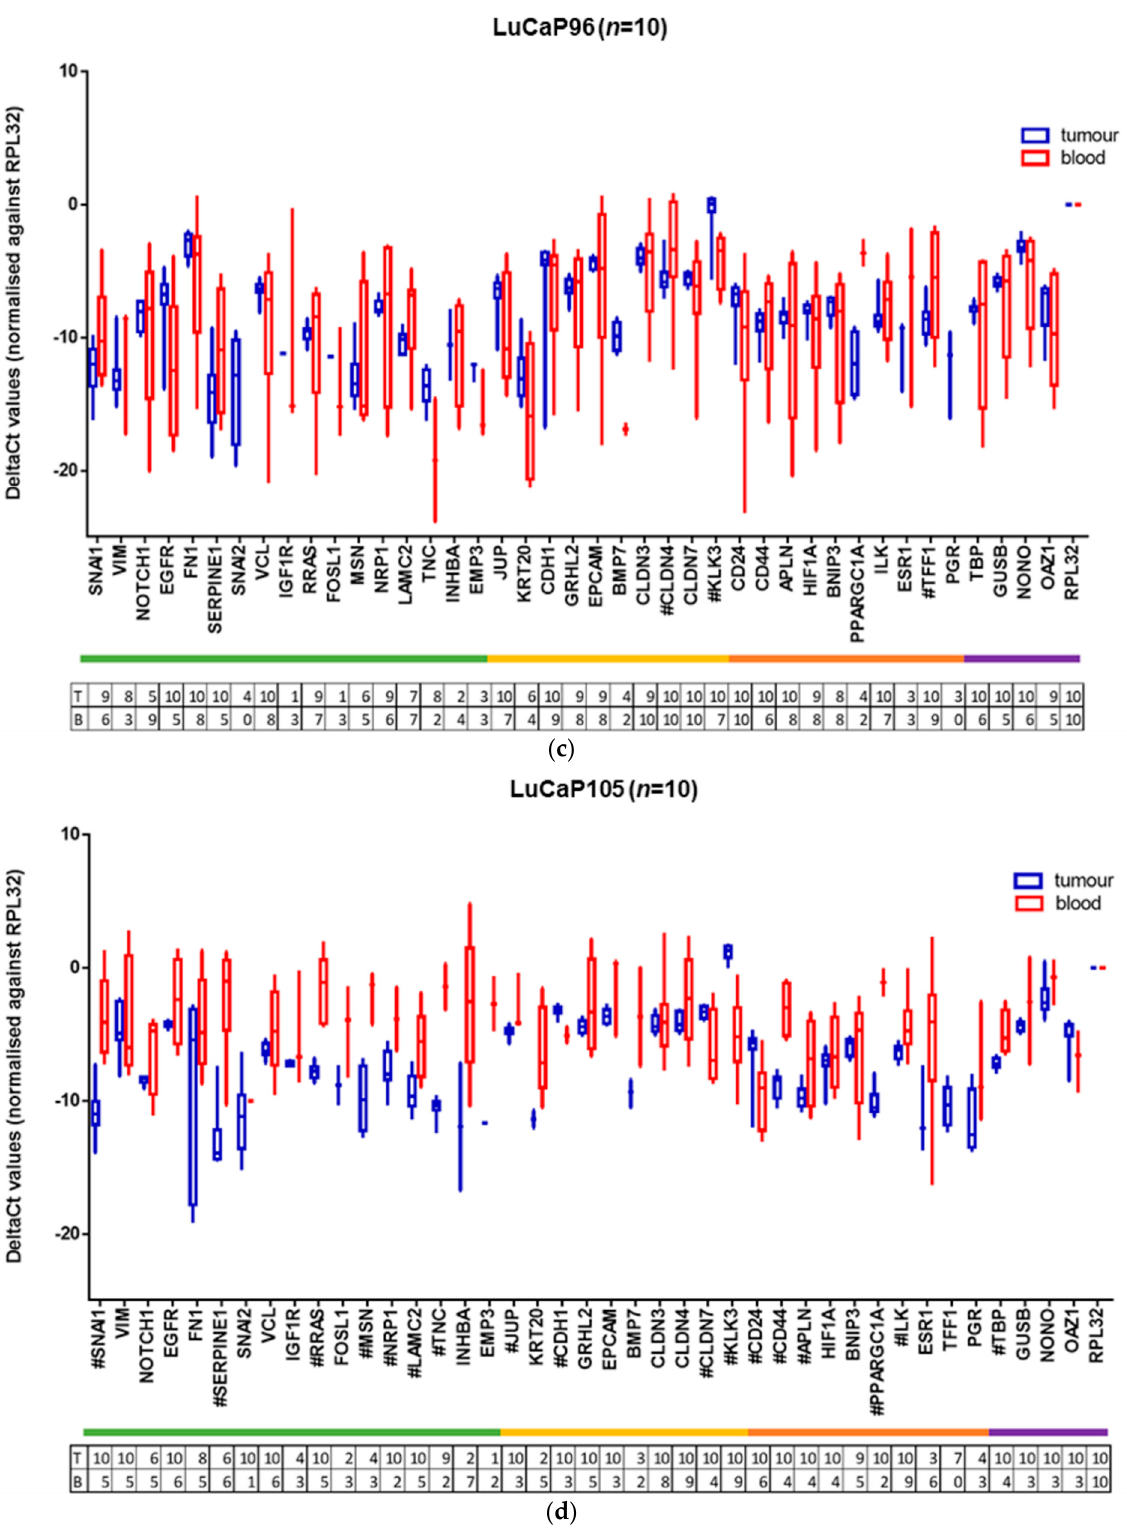
Figure 6. ( a – d ): Box and whisker plots for tumour (T) vs. blood (B) samples of the different prostate PDX grafted mice. ∆ Ct values are normalised to housekeeper gene RPL32 . Significant differences in gene expression values between CTCs and tumours were identified using the Benjamini, Krieger and Yekutieli two-stage linear step-up procedure to control the false discovery rate (Q = 5%, p < 0.05), and are marked with “#”. Numbers of samples included in each data point indicated in table below each graph. (Each tumour (T)/blood (B) pair is from a different mouse.)